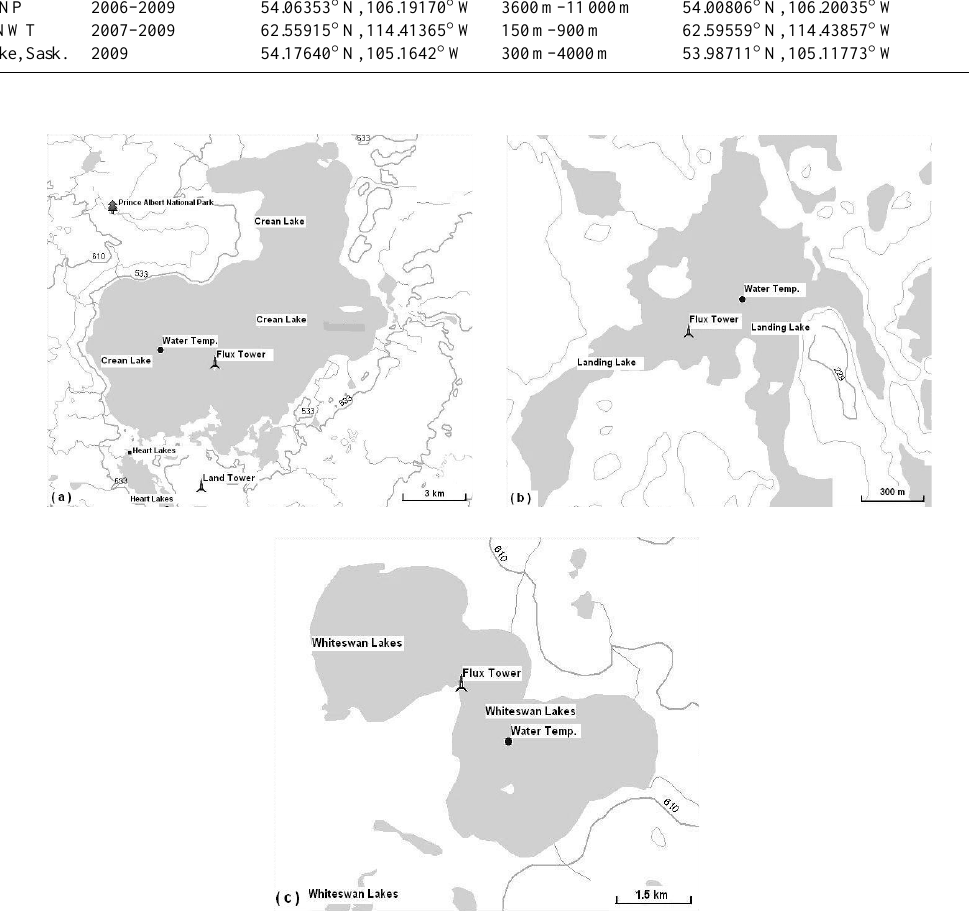
Figure 1. Instrumented Lakes showing location of instrument towers; a) Crean Lake, Prince Albert National Park, Saskatchewan; b) Landing Lake, North West Territory; c) Whiteswan4 Lake, Saskatchewan.